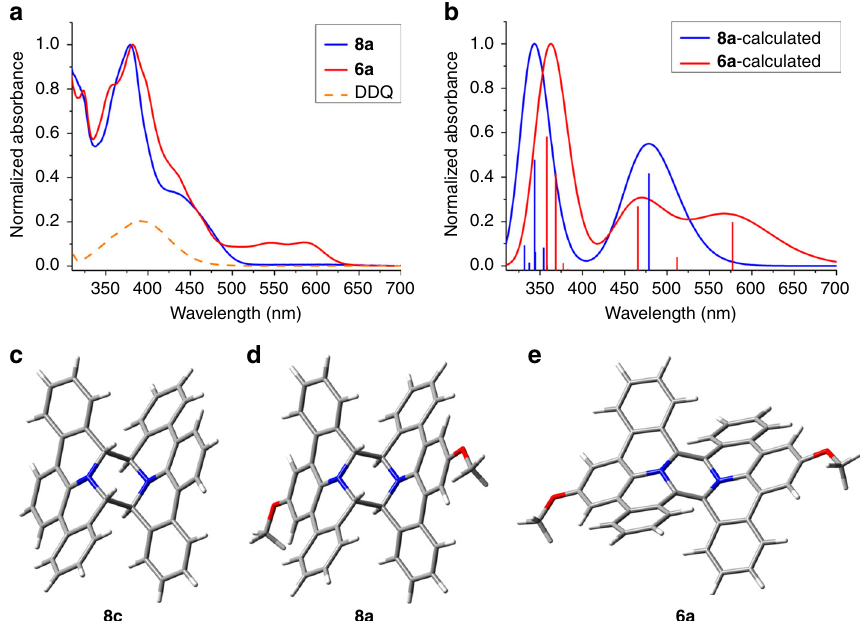
Fig. 4 Photophysical investigations. a Experimental and b TDDFT-simulated absorption spectra of 6a and its precursor 8a . The simulated spectra of 6a showed the appearance of a new band at 577 nm, in accordance with the experimental observation. c X-ray single-crystal structure of 8c . d DFT-optimized structure of 8a . e DFT-optimized structure of